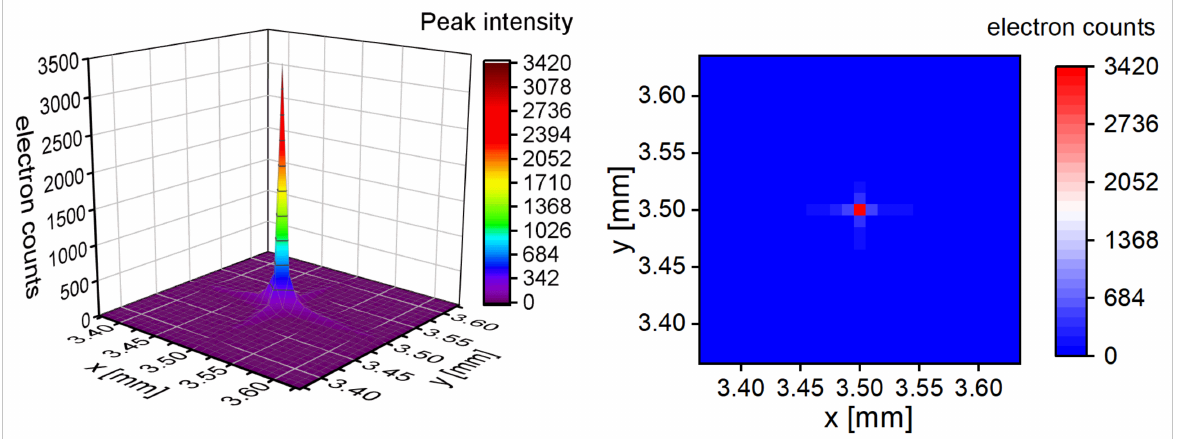
Figure 11. Three-dimensional plot and heat map for the best-focused beam with the 3 mm Einzel lens observed at the